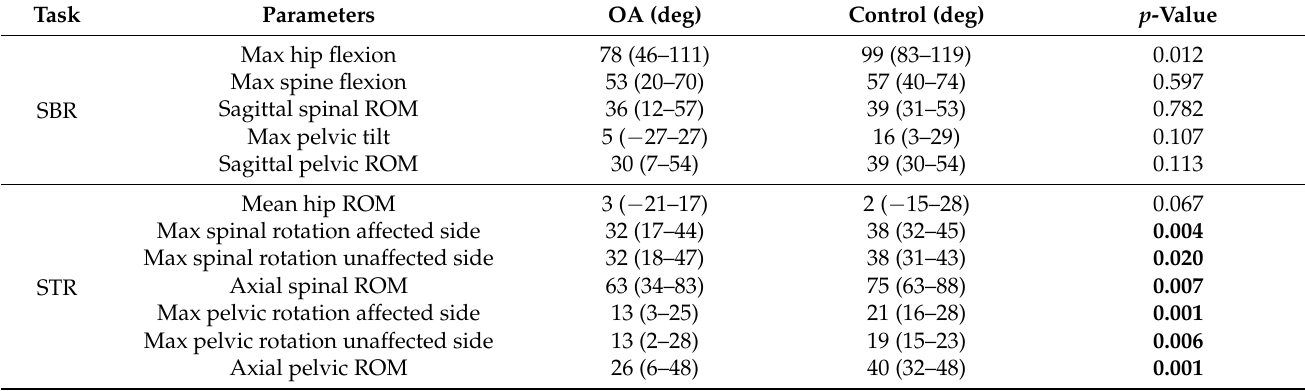
Table A1. Summary of kinematics ranges, and statistical significance between OA and Control groups, reporting mean